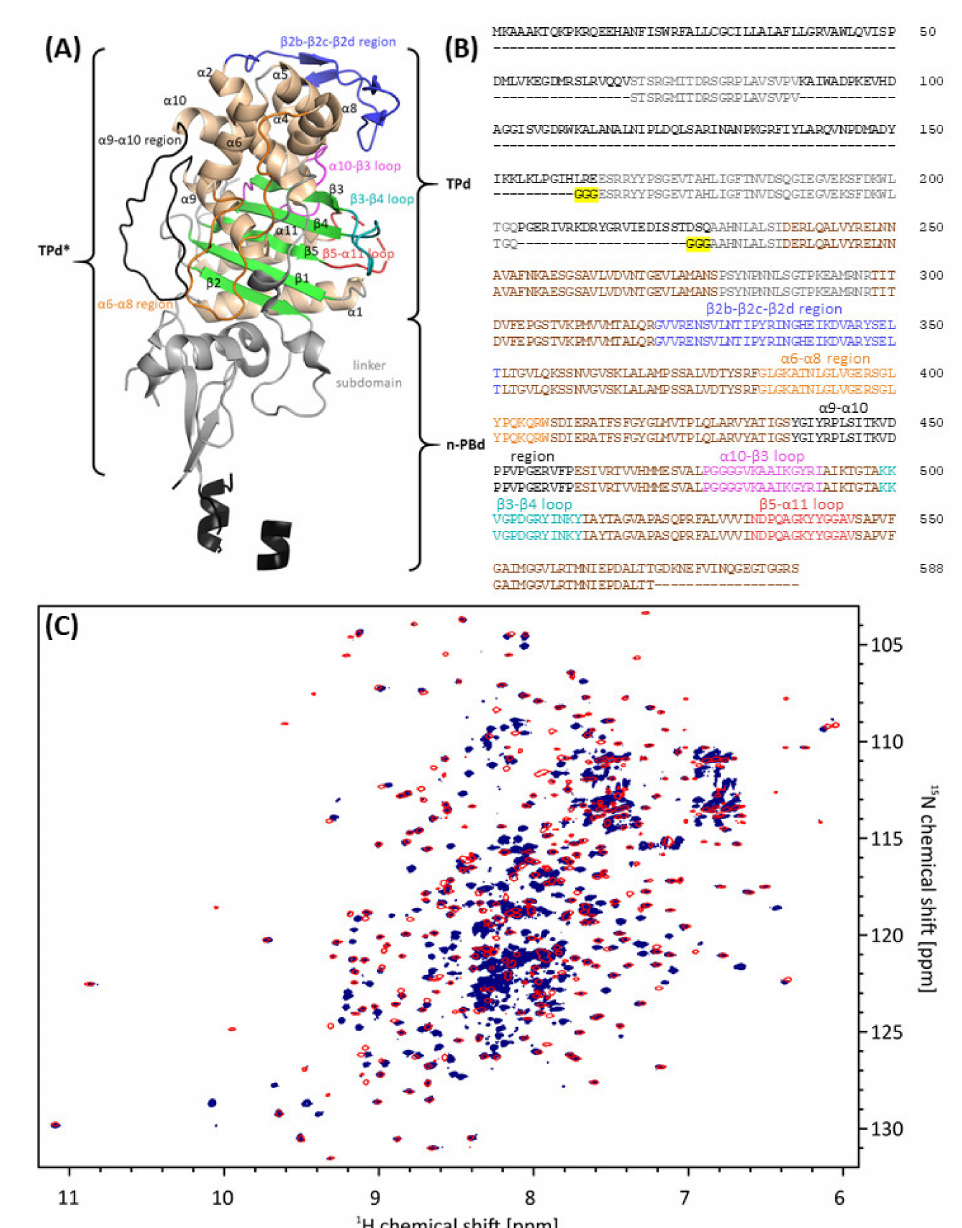
Figure 2. Design of an Ec TPd* construct for structural studies. ( A ) X-ray structure of Ec PBP3 ∆ TM published previously (PDB entry 4BJP, [13]). Secondary structure elements and intervening loops relevant to this paper are labeled. Note that the n-PBd of the elongated molecule has been traced only incompletely. ( B ) Sequence alignment of Ec PBP3 ∆ TM (upper sequence) and the newly designed Ec TPd* construct (bottom sequence) performed with Clustal Omega [41]. The structural elements labeled in ( A ) as well as the tri-glycine linkers (yellow background) are highlighted in the sequence. ( C ) Overlay of 2D 1 H- 15 N TROSY-HSQC NMR spectra of uniformly [ 2 H, 13 C, 15 N]-labeled Ec PBP3 ∆ TM (blue) and Ec TPd* (red) demonstrates the structural similarity of both proteins in